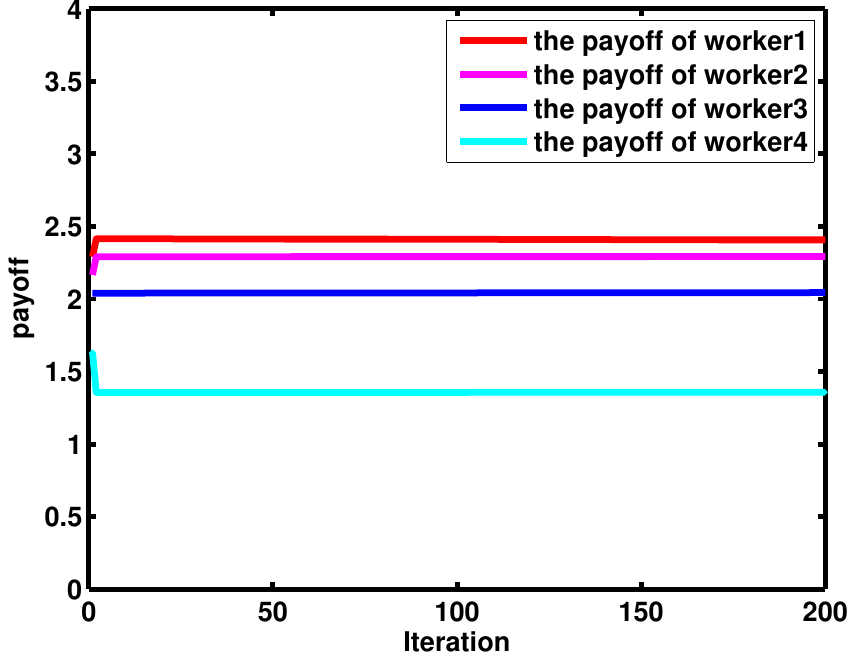
Figure 10. The payoff of 4 workers where worker 1 uses ZD1